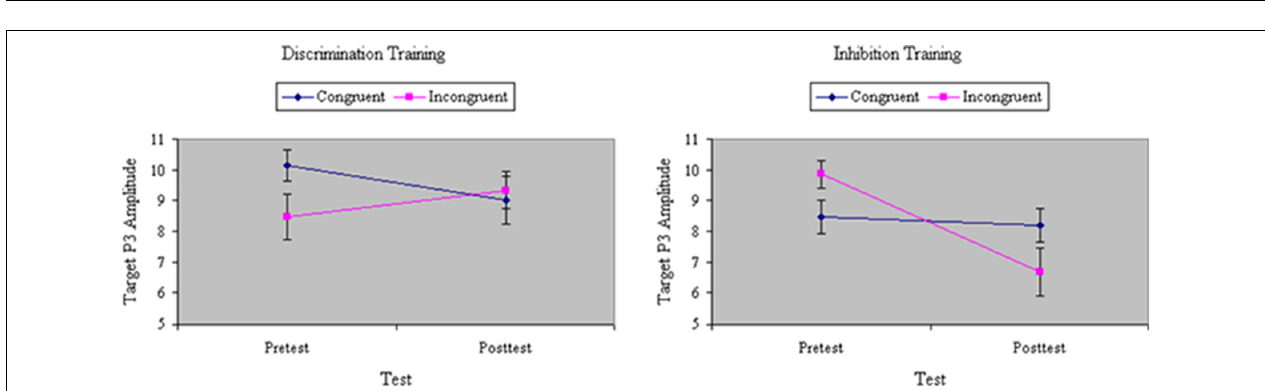
FIGURE 8 | Amplitude of P3 ERP component to targets (in microvolts) on congruent and incongruent trials in the filtering task at pretest and posttest in discrimination and inhibition training groups. Whereas inhibition training yielded a significant decrease in the amplitude of P3 to incongruent targets, discrimination training slightly boosted P3 to these stimuli, yielding a significant three-way interaction of Training, Group, and Congruity.